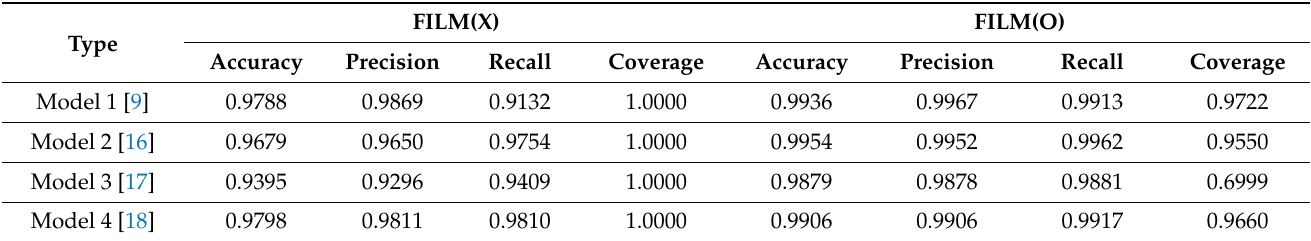
Table 3. Comparison of ML models with and without